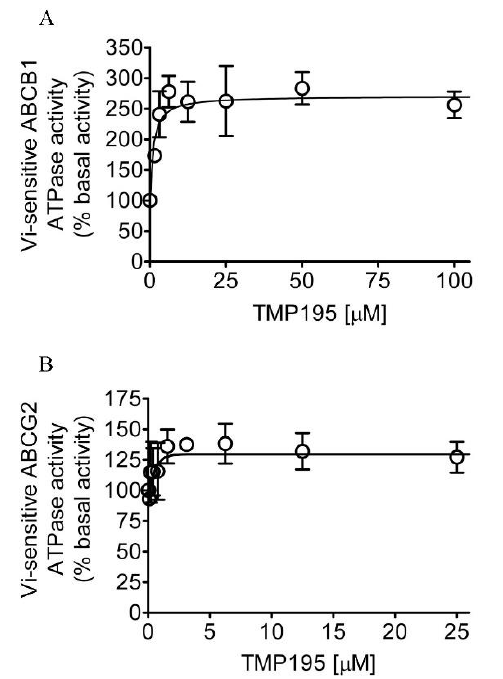
Figure 4. TMP195 stimulates ATPase activity of ABCB1 and ABCG2. The effect of TMP195 on vanadate-sensitive ATPase activity of ( A ) ABCB1 and ( B ) ABCG2 was determined by the endpoint P i assay as described in the Section 4. Data are presented as a mean ± SD from at least three independent experiments as a percentage of basal activity taken as 100%.